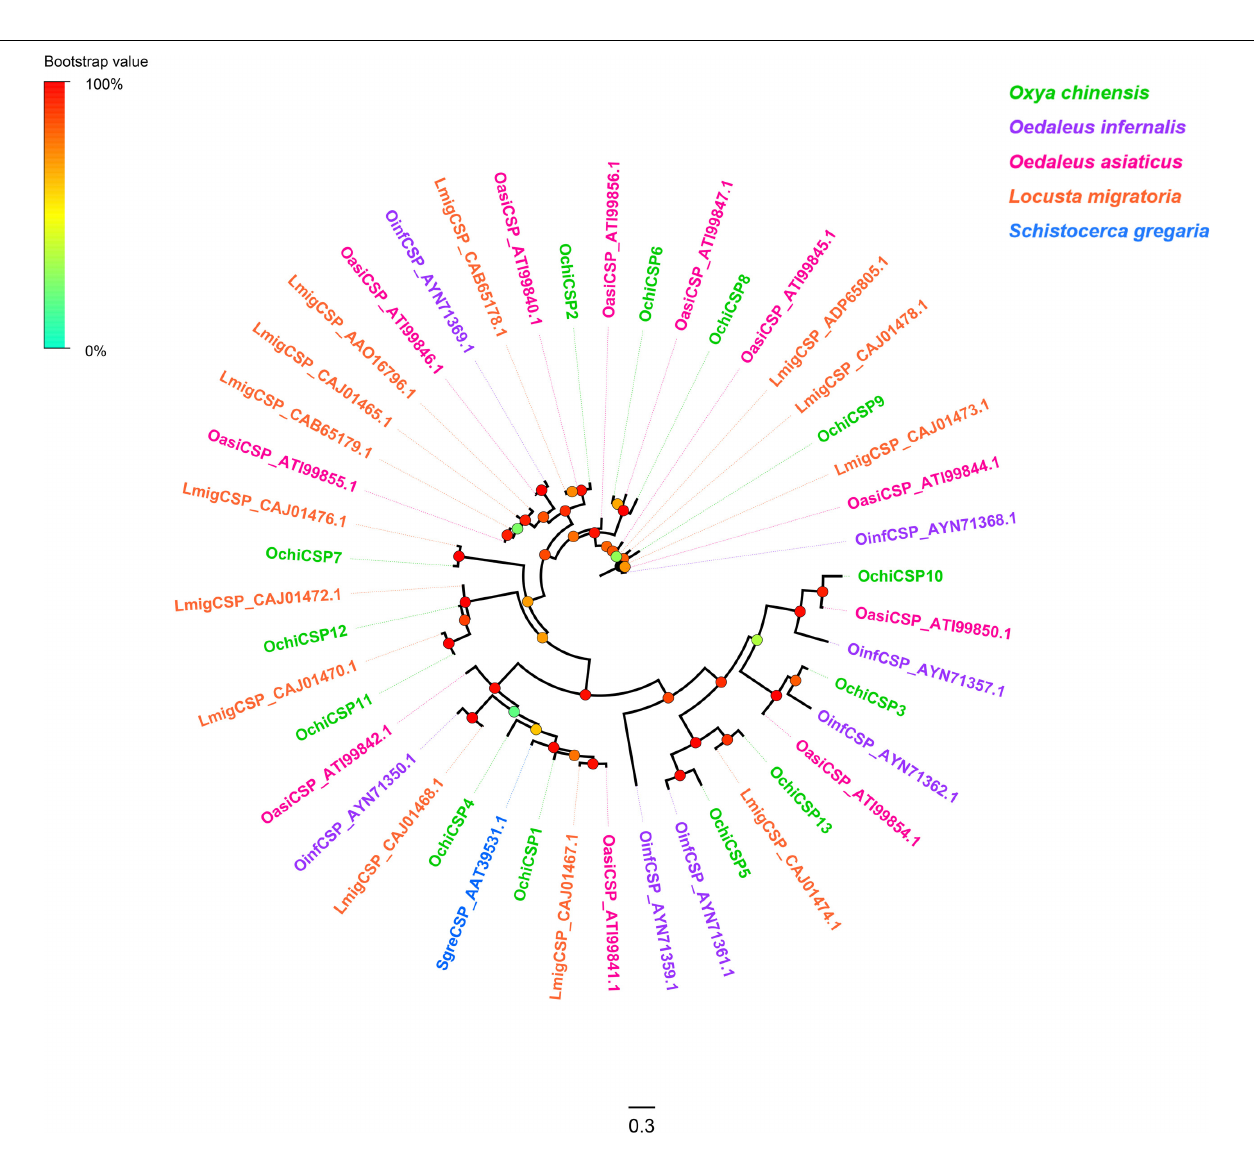
FIGURE 2 | Phylogenetic tree of putative chemosensory proteins (CSPs). Branch support (circles at the branch nodes) was estimated using an approximate likelihood ratio test based on the scale indicated at the top left. Bars indicate branch lengths in proportion to amino acid substitutions per site.